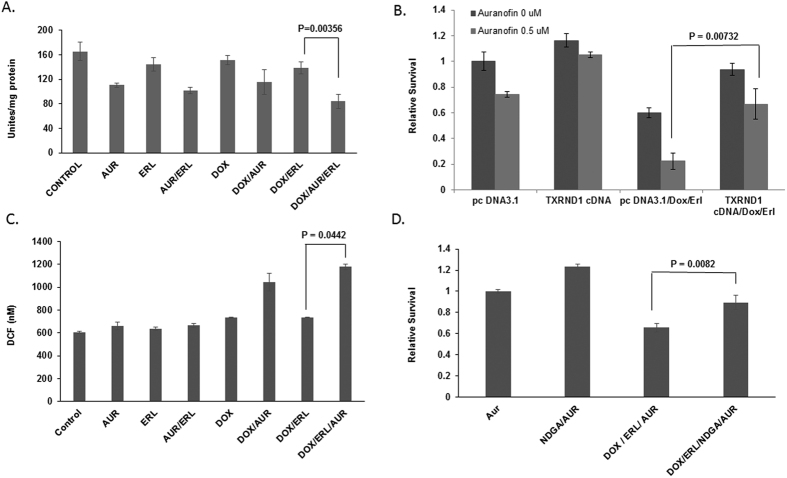
TRNXD1 inhibition renders cells more sensitive to TUSC2 and erlotinib treatment and involves increase in ROS levels.(A) Thioredoxin Reductase 1 (TXNRD1) activity was measured using Thioredoxin Reductase 1 (TXNRD1) Activity Assay Kit with TXNRD1 antibody. Following treatments, Tet-inducible TUSC2 H1299cell lysates were incubated in the absence or presence of DTT (10 mM) at 37 °C in TE buffer. TXNRD1 was purified using Chroma Spin TE-10 columns and incubated with increasing concentrations of NAPQI (0.1–100 μM) or DMSO. TXNRD1/insulin mixture (50 nM purified rat liver TXNRD1, 0.5 mM NADPH, and 170 μM insulin in TE buffer) was added and changes in absorbance at 340 nm were recorded. TXNRD1 activity was calculated as the linear change in absorbance per min and expressed as a percentage of the enzyme activity of DMSO-treated control samples. (B) H1299 cells were transfected with 1 μg TXNRD1 cDNA and treated as indicated before assayed for survival with XTT assay. (C) H1299 Tet-inducible TUSC2 cells were cultured in a black 96-well culture plates and washed with HBSS before incubation in 100 μl of 1X cell-permeable fluorogenic probe 2’, 7’-Dichlorodihydrofluorescin diacetate (DCFH-DA) at 37 °C for 60 minutes. After TUSC2 induction with 1 μg doxycycline for 24 hours, cells were treated with 0.7 μM auranofin and/or 0.9 μM erlotinib for two hours. All treatment were in triplicates. Fluorescence was analyzed with a fluorometric plate reader at 480/530 nm. Hydrogen peroxide, H2O2 at 1000 μM was used a positive control. DCFH-DA treatment was 60 minutes. (D) H1299 cells were treated with 5 μmol/L NDGA before exposure to the indicated treatments and assayed for cell survival with XTT assay. TUSC2 induction by doxycycline was confirmed by western blot in all experiments. Data shown represent the mean ± SE of three independent experiments.